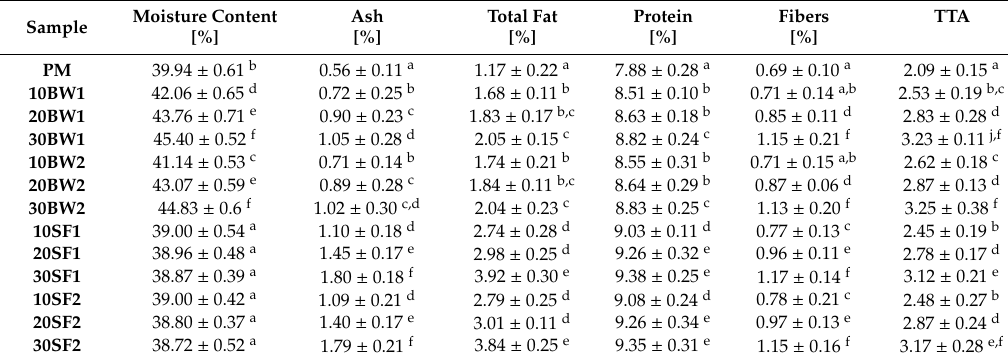
Table 6. Physico-chemical parameters of